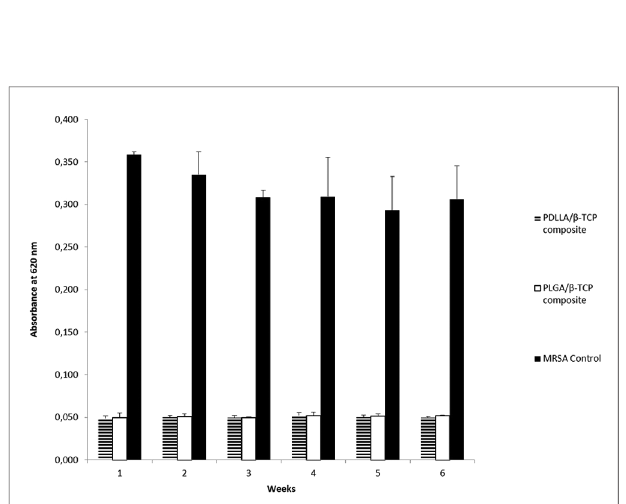
FIGURE 4 | Cumulative released vancomycin amount from the composites in 6 weeks. PDLLA, poly( D , L -lactide); PLGA, poly( D , L -lactide-co-glycolide); β - TCP, beta-tricalcium phosphate.